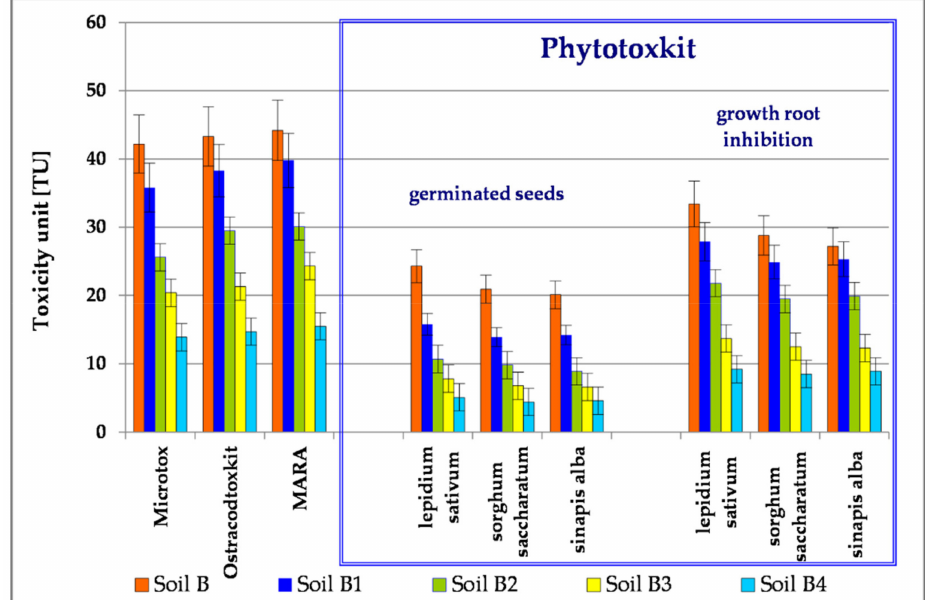
Figure 3. Comparison of the results of toxicity tests (expressed in TU toxicity units) of soil during the successive stages of biodegradation of petroleum pollutants—ex-situ method (repetition number n = 3, p < 0.05). (Soil B) raw soil; (Soil B1) soil after basic bioremediation; (Soil B2) soil after inoculation with I biopreparation (1st series); (Soil B3) soil after inoculation with I biopreparation (2nd series); (Soil B4) soil after inoculation with II biopreparation (3rd